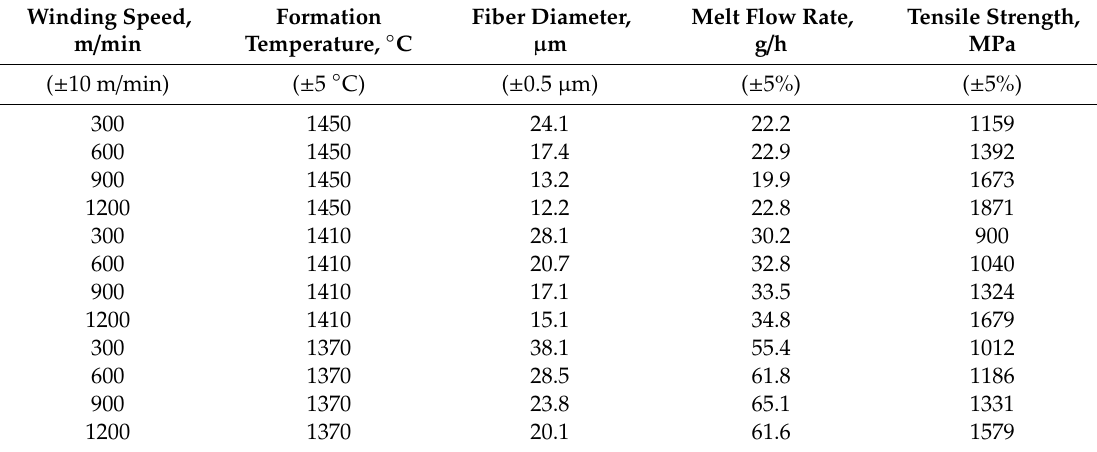
Table 2. Tensile strength of the fibers obtained under di ff erent process parameters using nozzle 2 (diameter 3.5 mm).